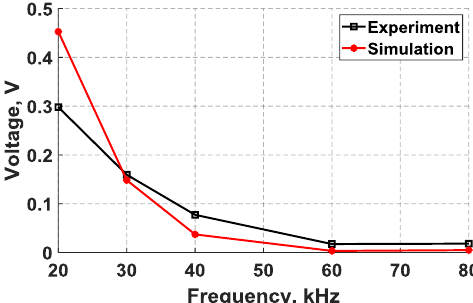
Figure 9. Maximum sensor voltage amplitude versus actuation frequency for flexural waves sensed and actuated by bondline-embedded d35 PZT transducers using a 5-peak actuation signal with a constant actuation voltage.